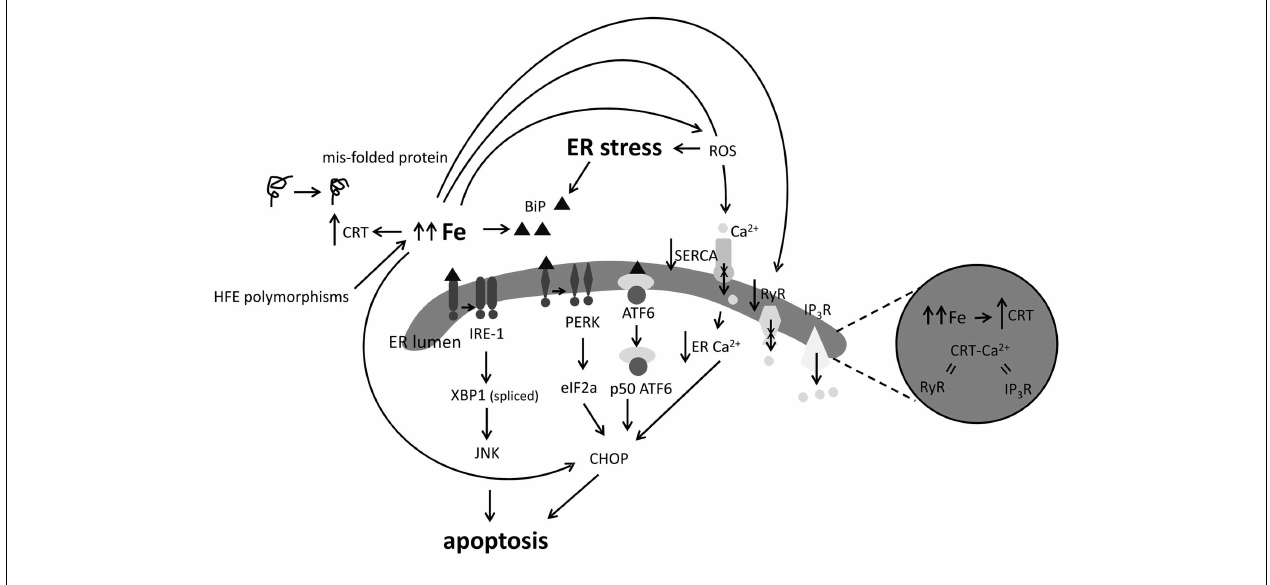
and resultant redox processes may inhibit function of the SERCA Ca 2 + pump, decreasing ER Ca 2 + levels, and leading to CHOP induction, on the other hand, Fe has been shown to inhibit the ryanodine receptor (RyR) ER Ca 2 + exporter. Induction of CRT by Fe could suggest that Fe participates in causing protein mis-folds or results in perturbed Ca 2 + balance in the